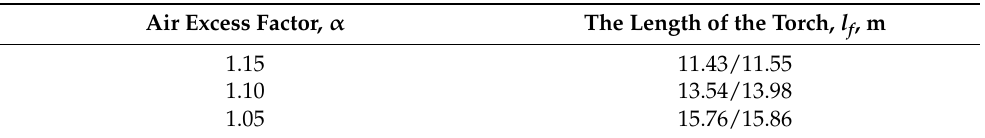
Table 6. Dependence of the torch length on the coefficient of excess air during natural gas combustion in rotary kilns/furnaces with